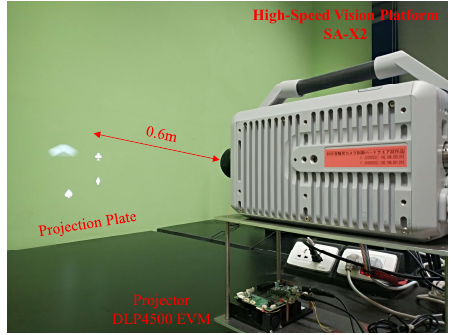
Figure 11. Overview of the experimental platform.